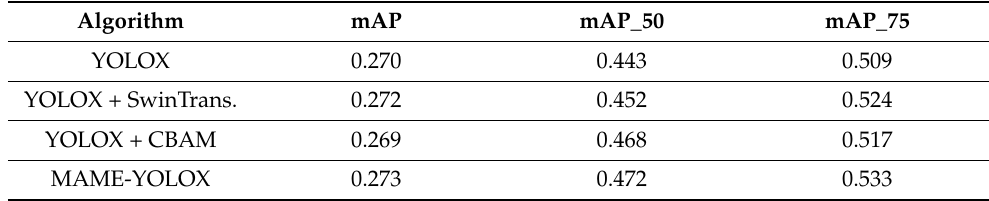
Table 9. The ablation experiments on the HRRSD dataset.